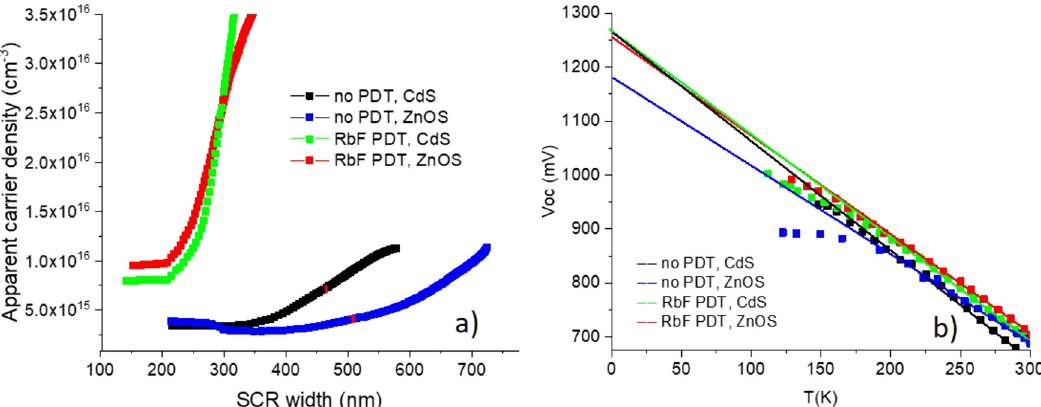
Fig. 3. (a) Apparent carrier density from the capacitance – voltage measurement. (b) V oc as a function of temperature for different cell